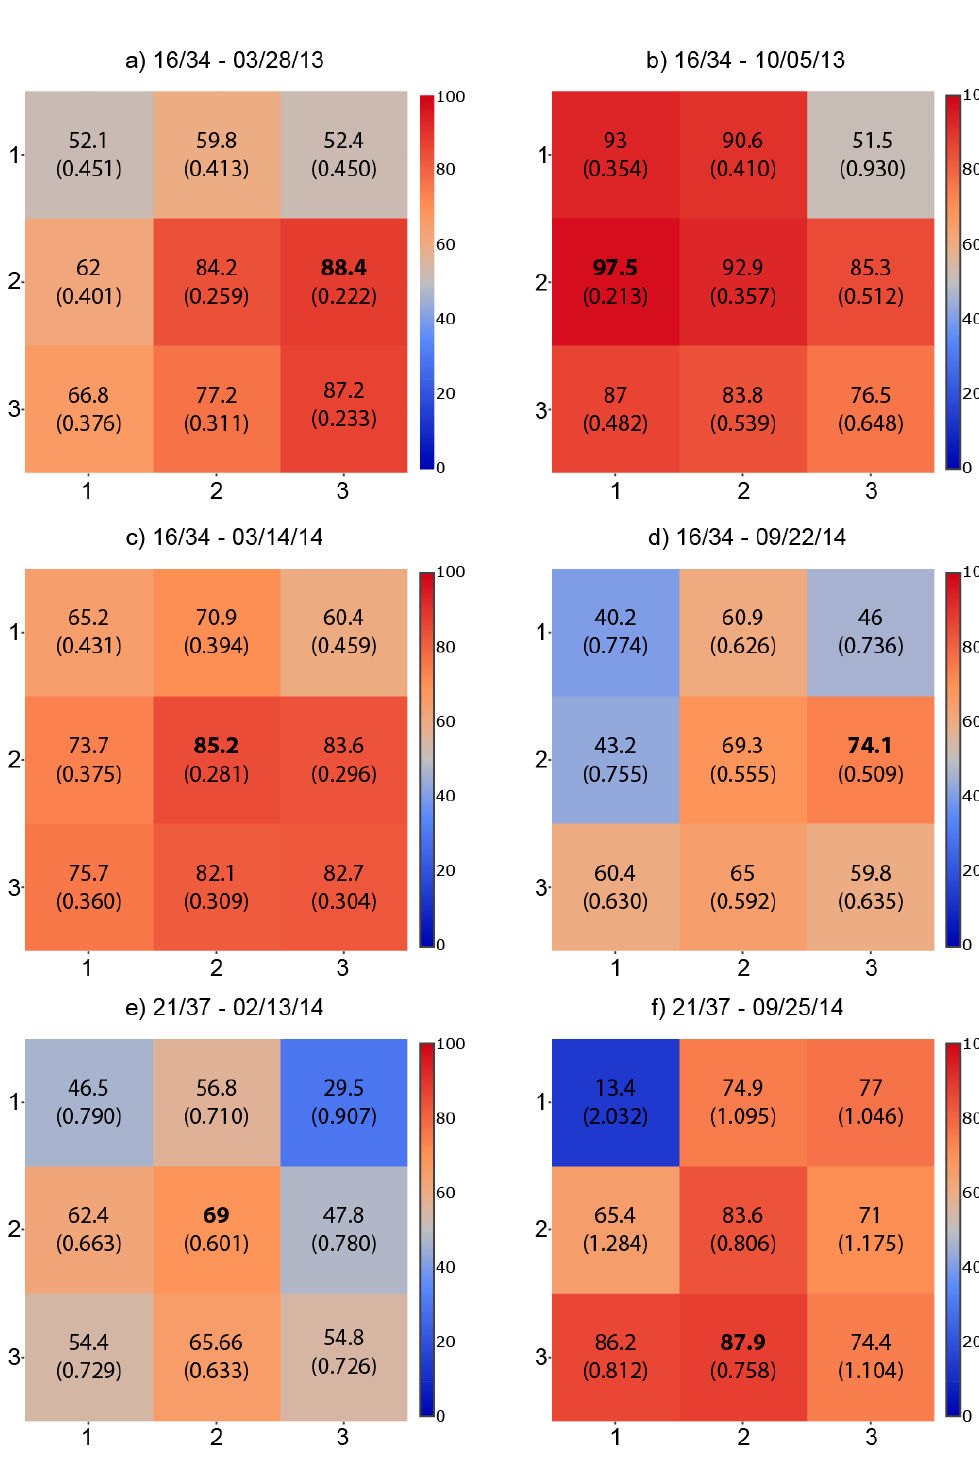
Figure 2. Regression results for Landsat OLI TOA reflectance based simple ratio vegetation index (SR) for each of the nine pixels surrounding or containing the LAI plot center and ground LAI estimates (bold R 2 s denote the regression with the best fit for the given ground data collection and image). Each cell contains the R 2 and (RMSE) for the given pixel (row, column) surrounding the plot center in pixel (2, 2).